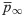
Long-term value p¯∞ of the fraction of cooperators versus the cost-to-benefit ratio ρ in the snowdrift game on empirical networks.(a) Γhepth. (b) Γastro. (c) Γfb. (d) Γinternet. The dashed lines show the asymptotic frequency of cooperators in a well-mixed population.